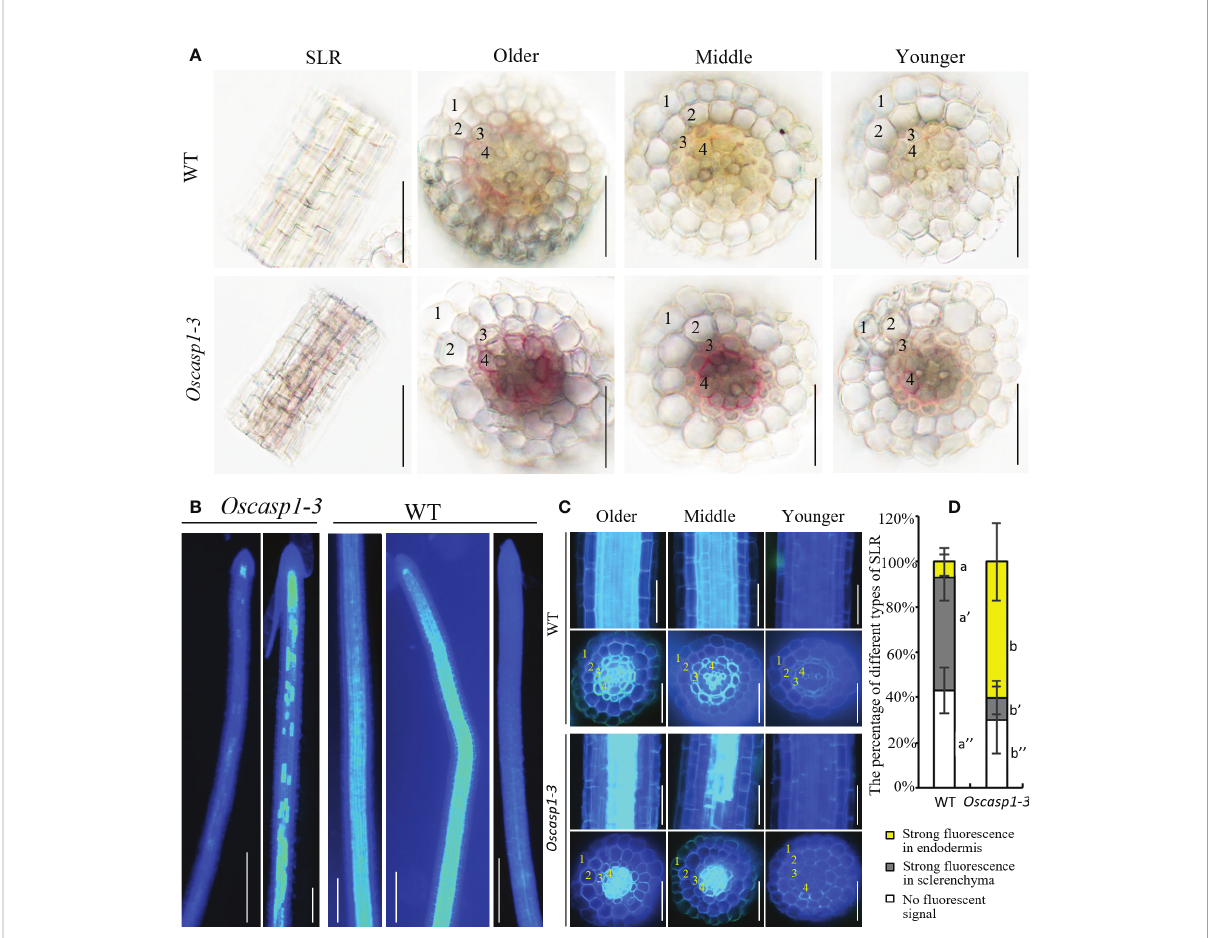
FIGURE 4 Characterization of the Oscasp1-3 mutant and WT SLRs stained with berberine-aniline blue and phloroglucinol. (A) The representative SLR regions and cross-sections stained with phloroglucinol. Scale bar = 50 m m. (B) The representative images of whole SLRs stained with berberine- aniline blue. Scale bar = 100 m m. (C) The representative SLR regions and cross-sections stained with berberine-aniline blue. Scale bar = 25 m m. (D) The percentage of different type of SLRs. Auto fl uorescence of cell walls is detected as blue. 1, epidermis; 2, exodermis; 3, sclerenchyma; 4, endodermis. Different letters denote signi fi cant differences in one-way ANOVA test (Tukey test p < 0.05) among different